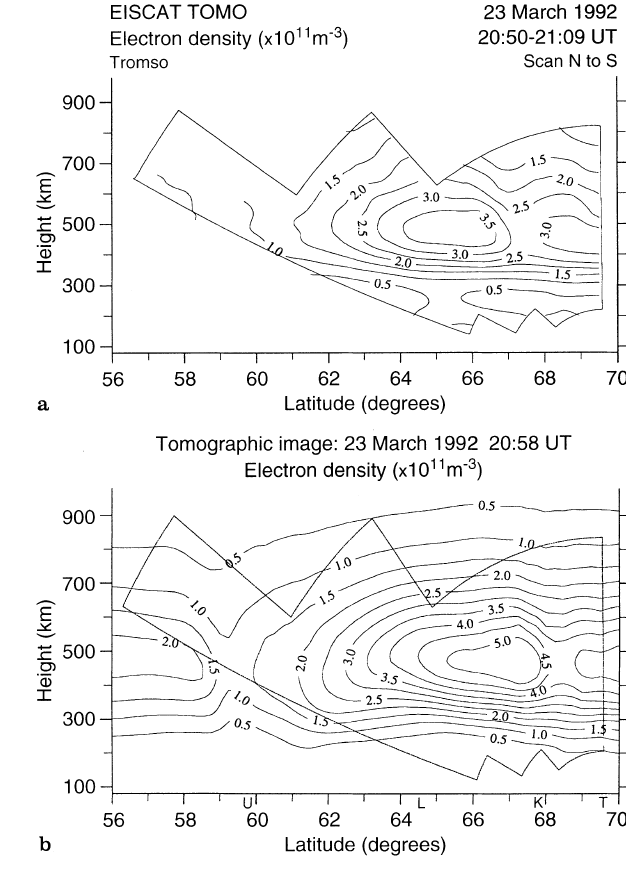
Fig. 4. a EISCAT SP-UK TOMO data from 20:50 to 21:09 UT and b tomographic image for a satellite pass at 20:58 UT on 23